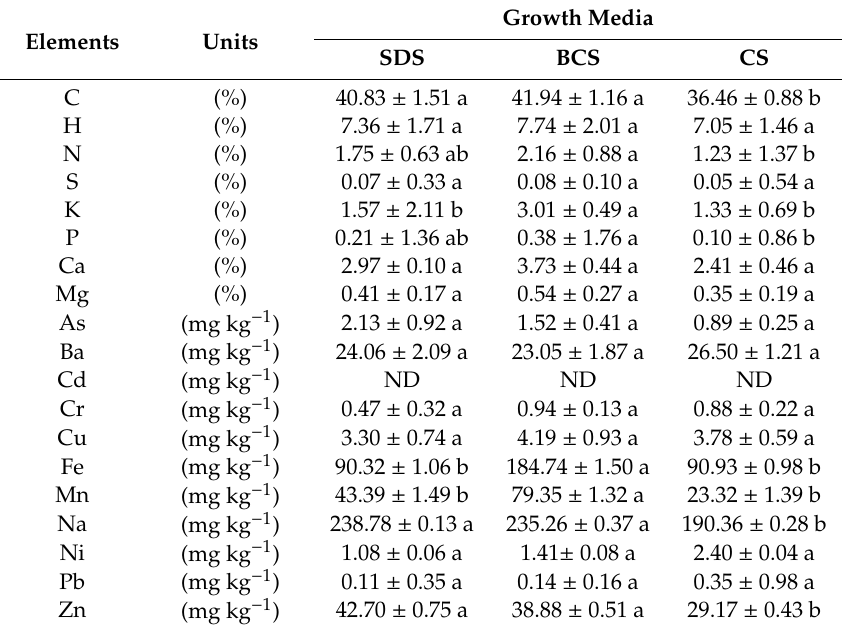
Table 3. Foliar nutrient content in a P. graveolens plant grown in di ff erent growth media. All values are means of three replicates ± standard deviation. SDS, solid digestate growth media; BCS, biochar growth media; CS, control growth